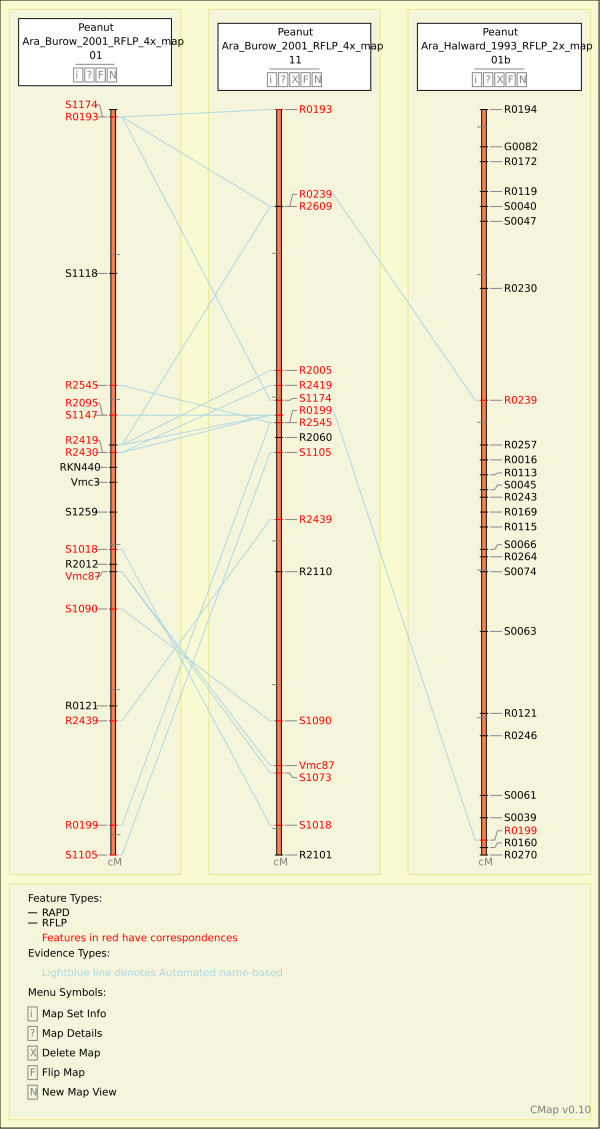
Comparison of linkage groups within and between different map sets. Three linkage groups are shown: linkage groups 1 and 11 from the tetraploid map, and 1b of the diploid map. Markers common to adjacent linkage groups are connected by lines.